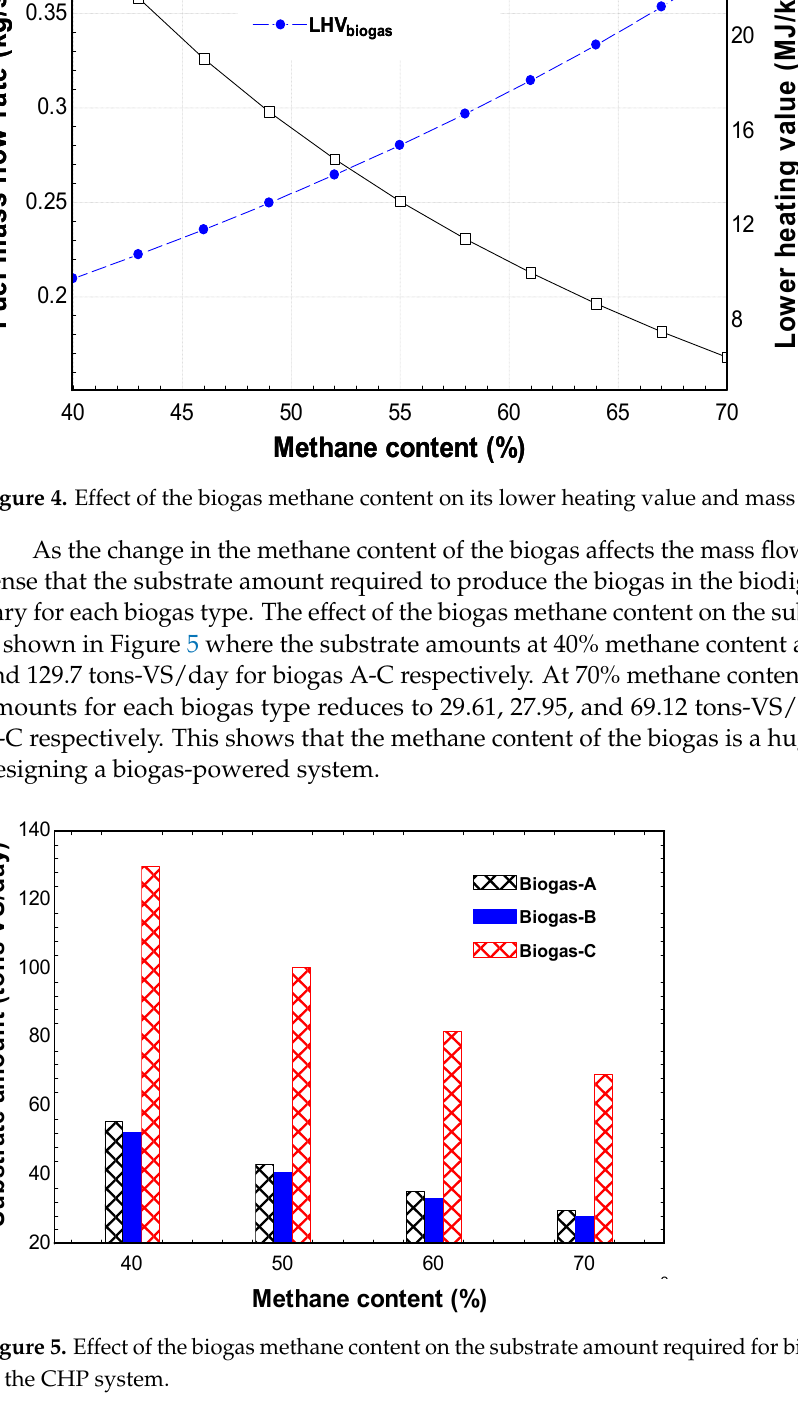
Figure 5. Effect of the biogas methane content on the substrate amount required for biogas production in the CHP system.